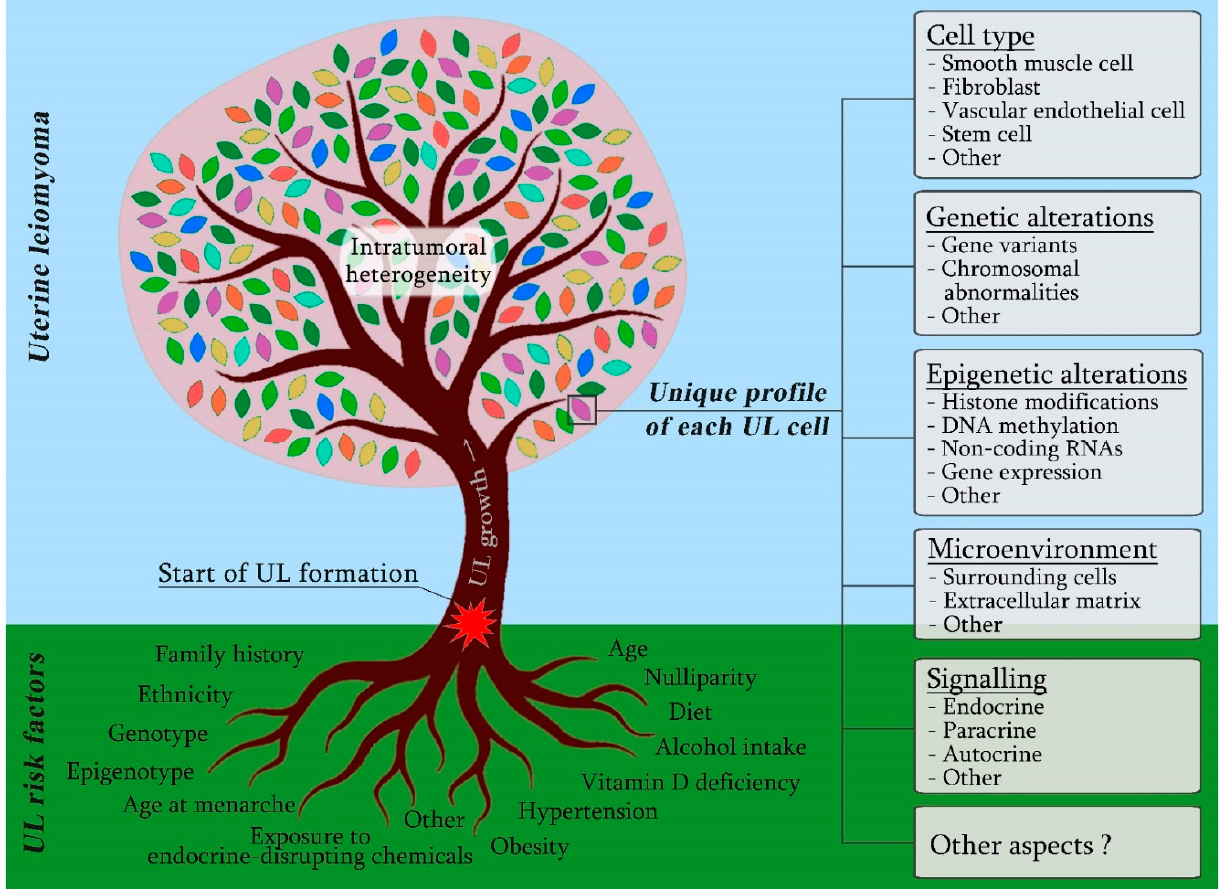
Figure 1. An illustration of predisposing factors intricacy and intratumoral heterogeneity complicating the search for key events of uterine leiomyoma (UL) genesis. UL formation is associated with a wide range of predisposing factors: family medical history, African or Latin American ethnicity, gene variants, epigenetic changes, early menarche, exposure to xenoestrogens, obesity, hypertension, vitamin D deficiency, alcohol intake, dietary habits, nulliparity and advanced reproductive age. During UL growth, each cell acquires a unique set of parameters (cell type, genetic and epigenetic alterations, characteristics of signalling and microenvironmental components), thus resulting in a pronounced intratumoral heterogeneity and complicating identification of the characteristics of initial UL cell(s).